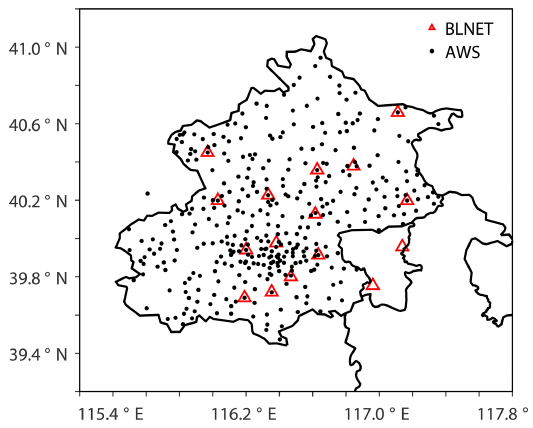
Figure 1. Spatial distributions of BLNET stations (red triangles), and ground-based automatic weather stations (black dots) in the Beijing